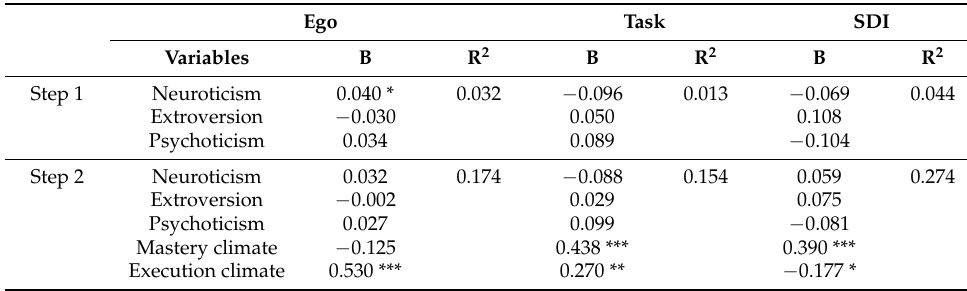
Table 2. Hierarchical regression analysis (dependent variables: target orientations; independent variables: personality variables, dimensions of motivational climate, and